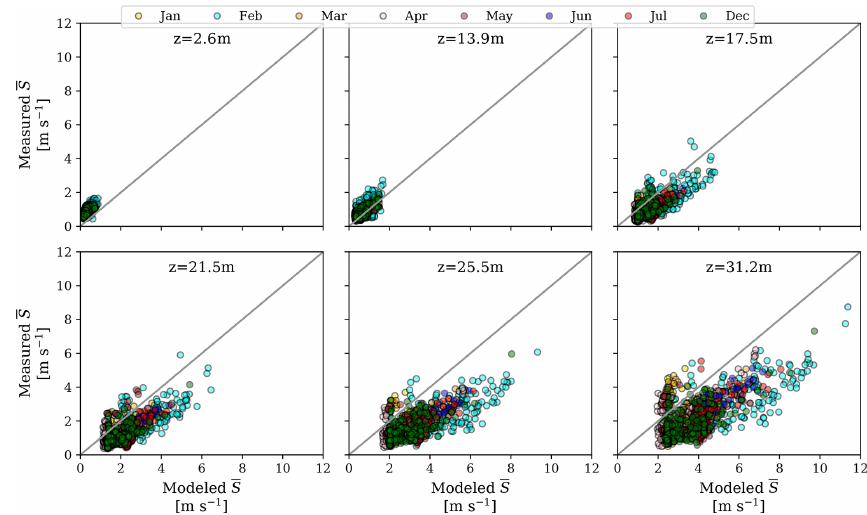
Figure 5. Scatter plots of observed (BUBBLE) versus simulated (VCWG) values of wind speed for different altitudes and months; each data point corresponds to a 1h comparison between the model and